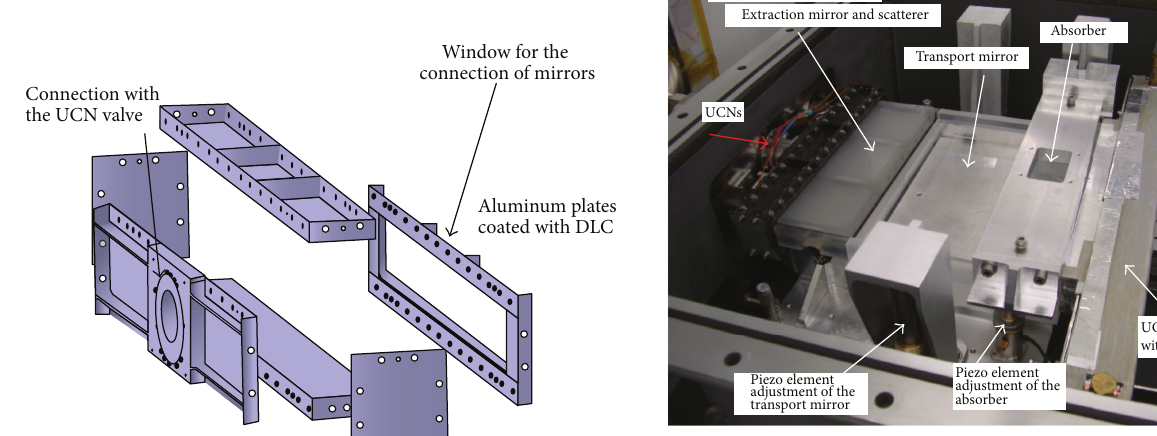
Figure 17: The optical elements on the granit table. The extraction mirrors assembly and the transport mirror are placed on two separate adjustable supports. Their adjustment could be done with 3 + 3 micrometric screws. To adjust the height and the orientation of the surface of the transport mirror with a great accuracy, we use 3 piezo-electric elements. The distance between the absorber and the transportmirroris adjustableas well using 3 piezo-electric elements. The piezos are driven from the control computer with a Labview